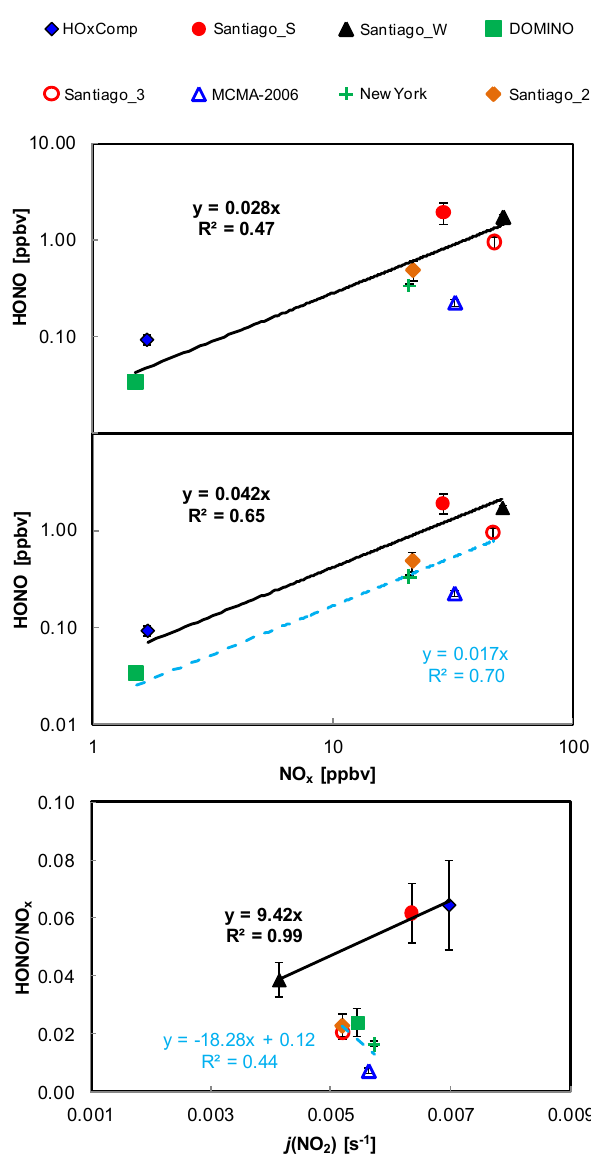
Fig. 8. Correlations between average afternoon (sector C, mid-noon to sunset) HONO mixing ratios versus the corresponding NO x and j (NO 2 ) values observed in different measurement campaigns. Error bars represent 1 σ of the mean.